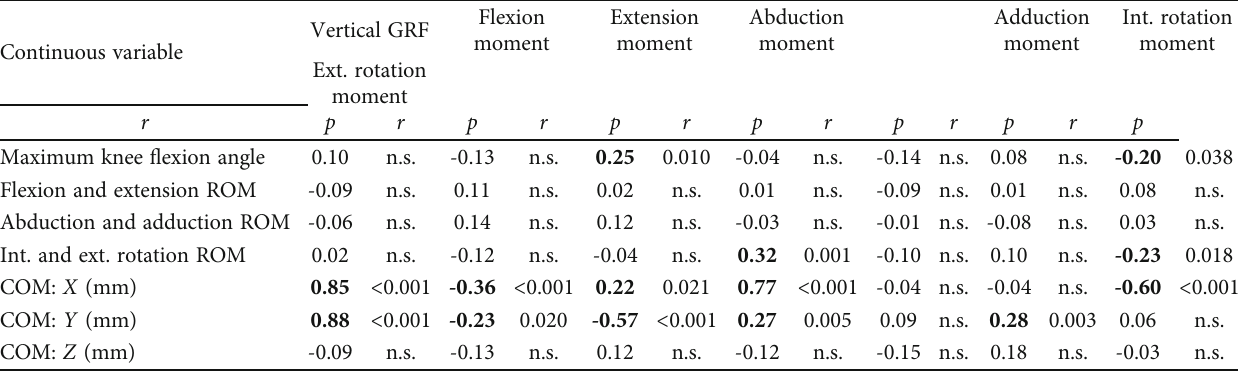
Table 3: Partial correlation analysis of knee joint range of motion (ROM) and center of mass (COM) displacement on knee joint load. Continuous